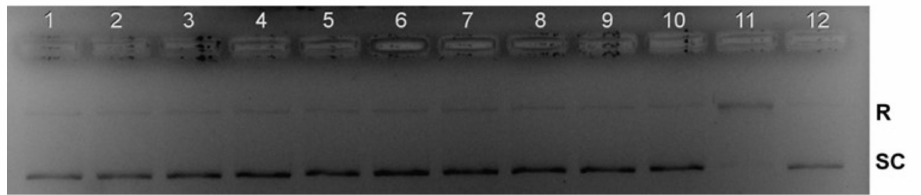
Figure 14. The inhibition of human Topo I by different concentrations of silver(I) dipeptide complexes. Lanes 1–3: pBR322 + Topo I + AgGlyGly; Lanes 4–6: pBR322 + Topo I + AgGlyAla; Lanes 7–9: pBR322 + Topo I + AgGlyAsp, Lane 10: pBR322; Lane 11: pBR322 + Topo I; Lane 12: pBR322 + Topo I + camptothecin. SC: supercoiled DNA, R: relaxed